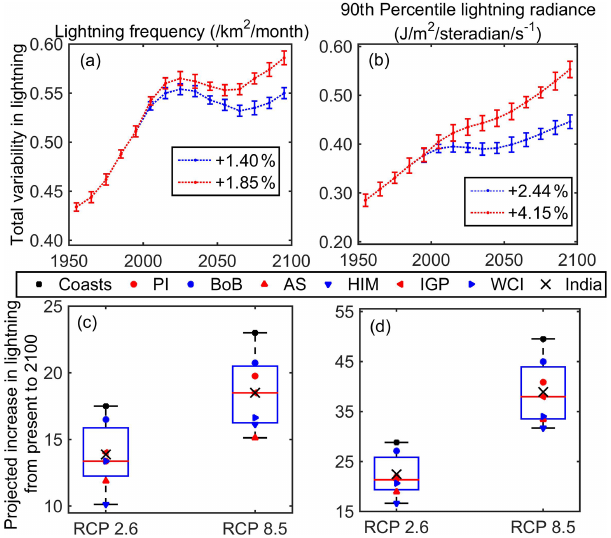
Figure 7. The 150-year multi-model, India-wide average projec- tions of (a) lightning occurrences and (b) the 90th percentile ra- diance using the RCP2.6 and RCP8.5 scenarios. (c, d) The zonal distribution of trends in lightning occurrence and intensity between the present decade (2011–2020) and 2091–2100. Legends in the top panels indicate the 5-yearly linear and significant trends in these pa-